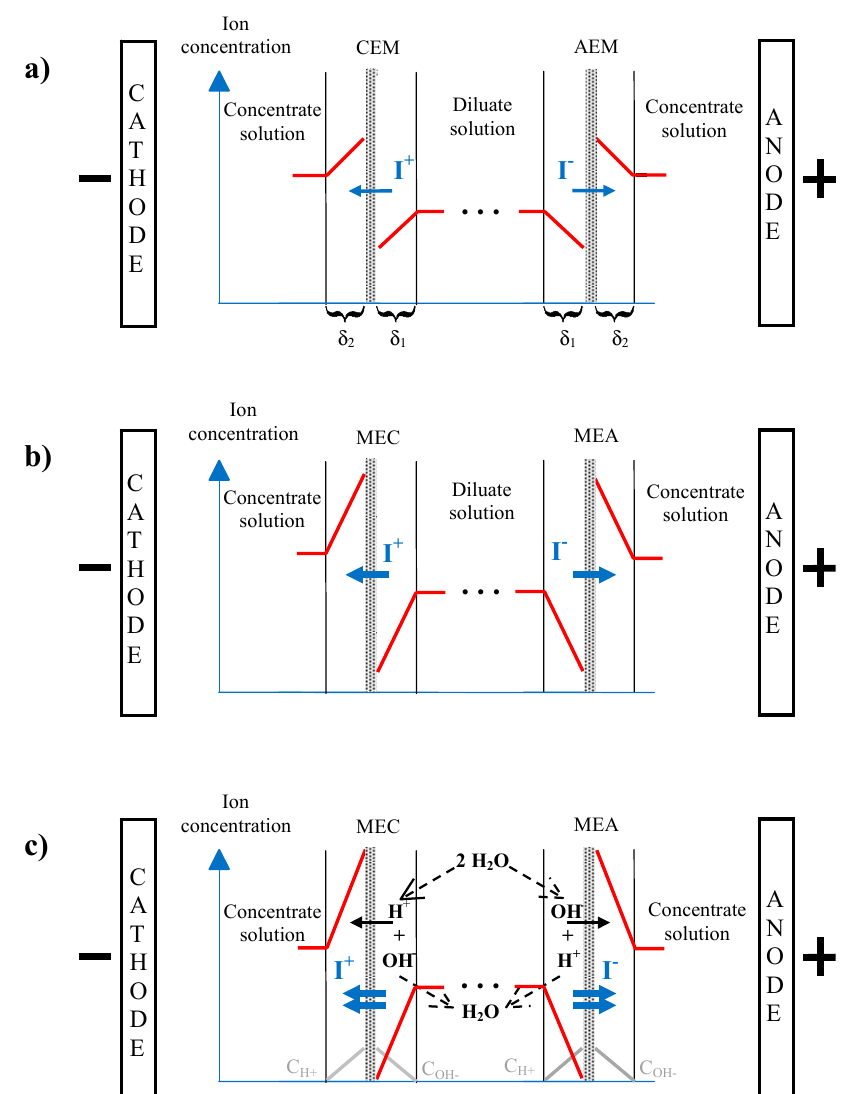
Figure 5. Steps in concentration polarization phenomenon at membrane interface during electrodialysis: ( a ) formation of concentration gradients, ( b ) reaching the limiting current density and, ( c ) overpassing the limiting current density and irreversible water dissociation. CEM: cation-exchange membrane; AEM: anion-exchange membrane; δ 1 : diluate boundary layer; δ 2 : concentrate boundary layer; C H + : concentration in H + and C OH − : concentration in OH − (Adapted from Bazinet [22]).